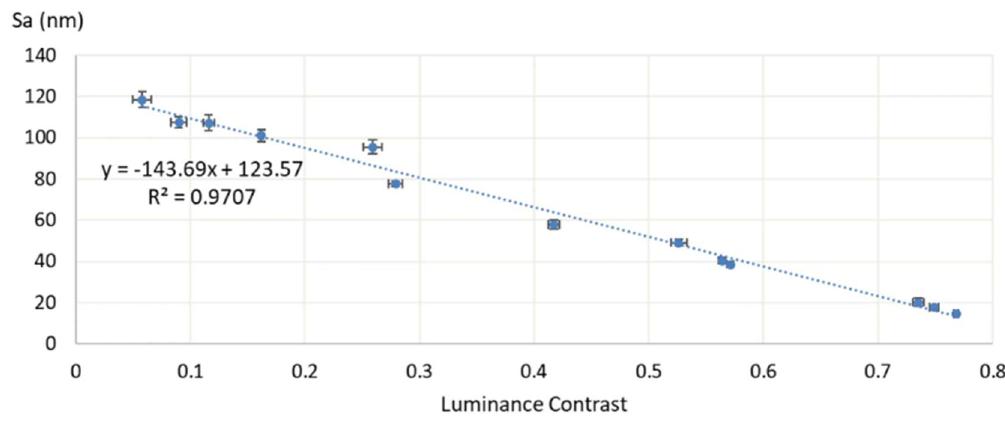
Figure 10. Sa -contrast curve.